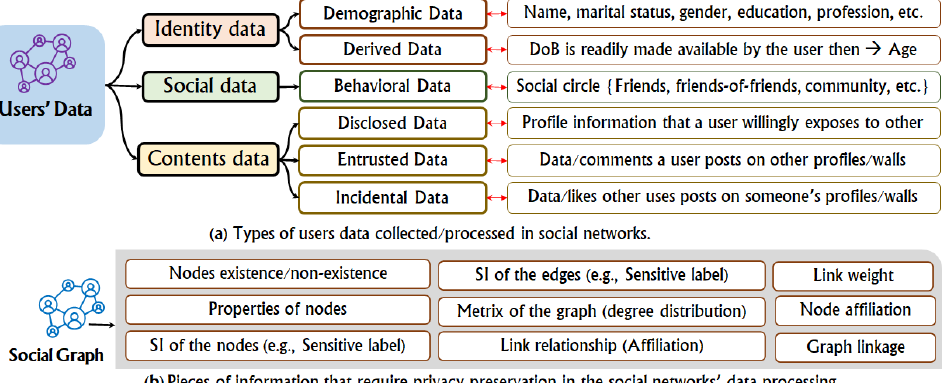
Figure 7. Different types of SN data and pieces of information concerning privacy in social graphs.